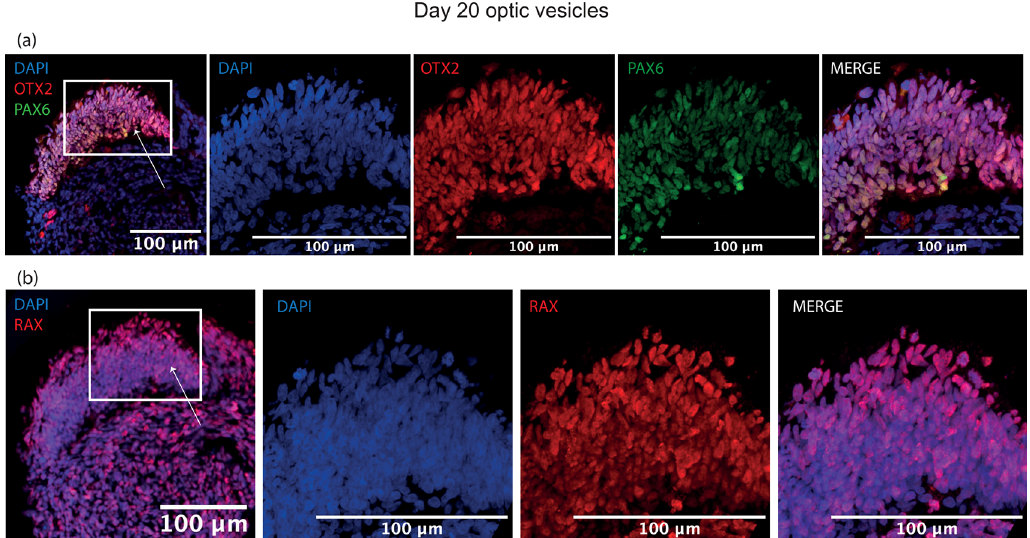
Figure4.Representativeimagesofimmunohistochemistrysectionsofdifferentiatingopticvesiclesatday20. Expression of early eye-field transcription factors (a) OTX2, PAX6 and (b) RAX is expressed in neuroepithelium at day 20 in optic vesicles. Arrows indicate neuroepithelial layer seen in zoomed